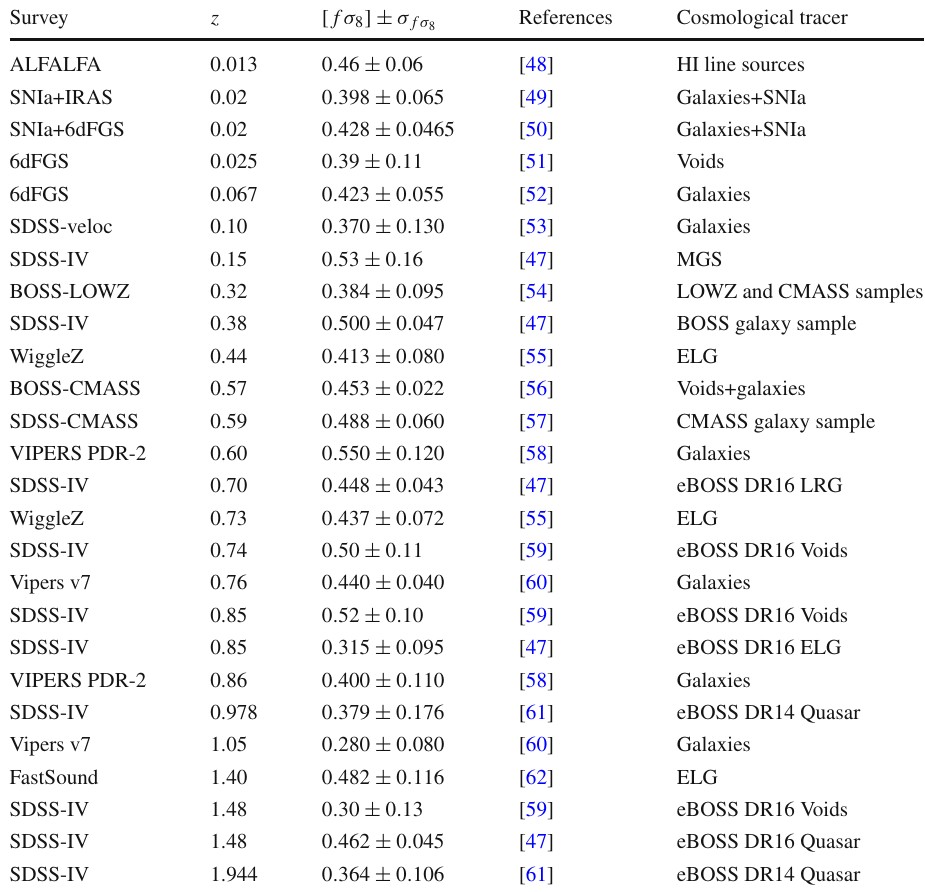
Table 2 Updated compilation of 26 [ f σ 8 ] ( z ) data with their